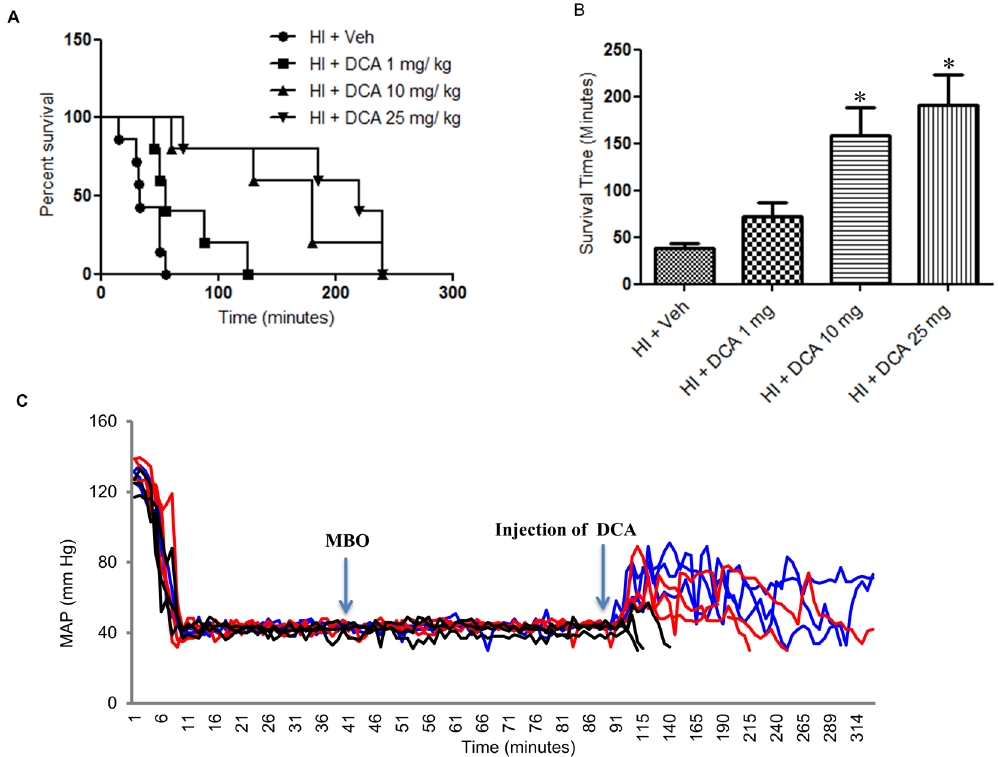
Figure 1. Dichloroacetate (DCA) prolongs life after HI in the absence of resuscitation. ( A) Kaplan-Meier survival curves. HI + Veh (n = 7), HI + DCA 1 mg/Kg (n = 5), HI + DCA 10 mg/Kg (n = 5) and HI + DCA 25 mg/Kg (n = 5) p < 0.05 versus HI + Veh, all curves. ( B ) Bar diagram represents mean survival time (minutes) in each of experimental groups (mean ± SEM); * indicates p < 0.05 compared HI + Veh; ( C) Time course of mean arterial pressure (MAP) from the onset of hemorrhage to immediately prior to euthanasia in representative animals in HI + Veh (black lines), HI + DCA 10 mg/Kg (red line) and HI + DCA 25 mg/Kg (blue line); only three representative animals shown for each group. MBO = maximum bleed out, time at which hemorrhage